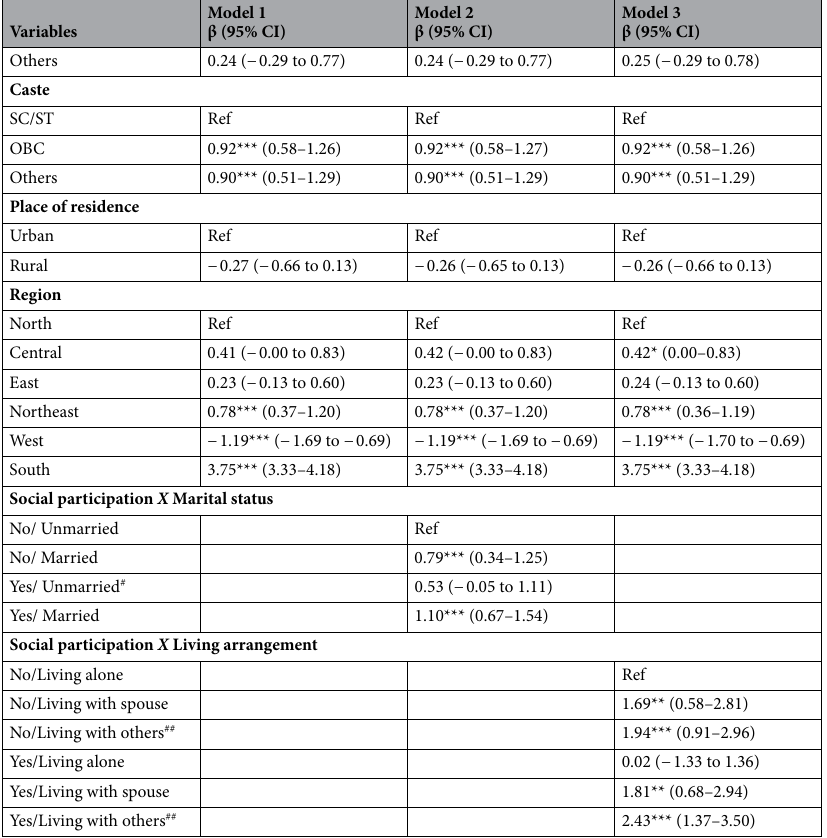
Table 3. Association of social participation and other variables with life satisfaction among older adults, LASI Wave 1, 2017–18. Ref.: Reference Category; *if p < 0.05, **if p < 0.01, ***if p < 0.001. CI confidence interval, X interaction, SRH self-rated health, ADL activities of daily living, IADL instrumental activities of daily living, MPCE monthly per capita consumption expenditure. # Currently unmarried category comprises widowed, divorced, separated, deserted and never married older individuals. ## Category of living with others consists of those older adults who were co-residing either with their spouse and children, living with spouse and other relatives, and living with children and/or other